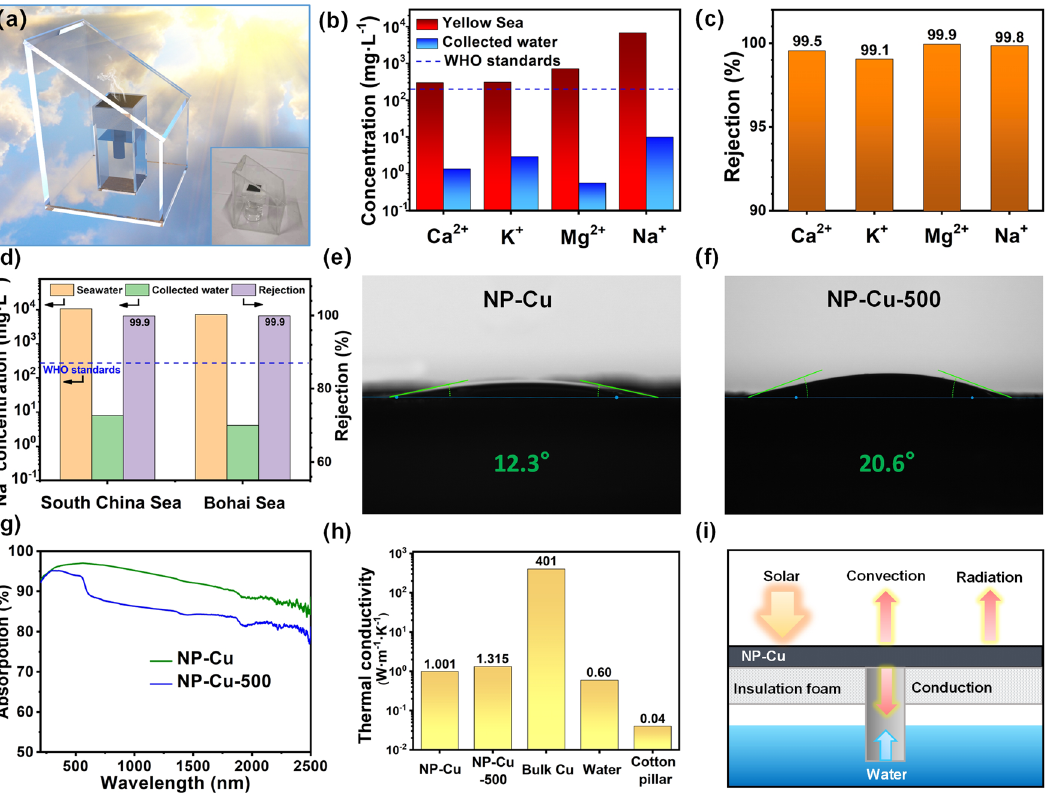
Fig. 6 a Schematic illustration of steam condensation recovery device. Inset: photograph of the device. b Concentrations of four metal ions in Yellow Sea and the collected clean water after desalination by the NP-Cu film. c Ion rejection of real seawater sample after desalination. d Na + concentrations in seawater (South China Sea and Bohai Sea) and the collected clean water after desalination by the NP-Cu film and correspond- ing rejection. e , f Contact angles of the e NP-Cu and f NP-Cu-500 films. g UV-vis-NIR absorption spectra of the NP-Cu and NP-Cu-500 films. h Summary of thermal conductivities for some related materials. i Schematic diagram of heat